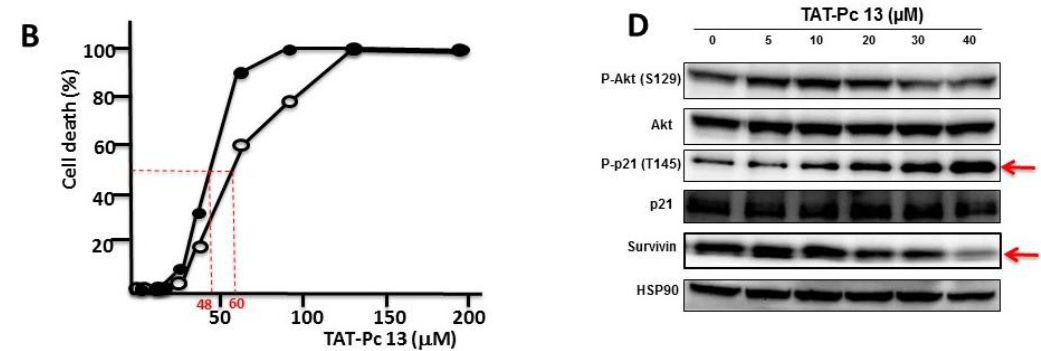
Figure 8. Cellular effects of TAT-Pc 13. ( A ) MCF-10A cells were incubated with 25 µM of TAT-Pc 13 for 3 h and imaged with phase microscopy (upper panel) or with increasing concentrations of TAT-Pc 13 for 2 h and cell viability was evaluated using the LIVE&DEAD™ assay. Live cells fluoresce bright green (530 nm), whereas dead cells fluoresce red-orange (645 nm) (lower panel, scale bare: 100 µm); ( B ) WT ( ○ - ○ ) or CK2β-depleted ( ⦁ - ⦁ ) MCF-10A cells were incubated for 4 h with increasing concentrations of TAT-Pc 13 and cell death was evaluated using the LIVE&DEAD™ assay recording fluorescence at 645 nm. Representative data shown from two independent experiments in duplicate; ( C ) MCF-10A cells were pre-treated in the absence or presence of 20 µM z-VAD for 5 h and then incubated for 4 h with 25 µM random TAT-Pc 13 or TAT-Pc 13 and cell viability was evaluated as in (A) (scale bare: 100 µm); and ( D ) intracellular events induced